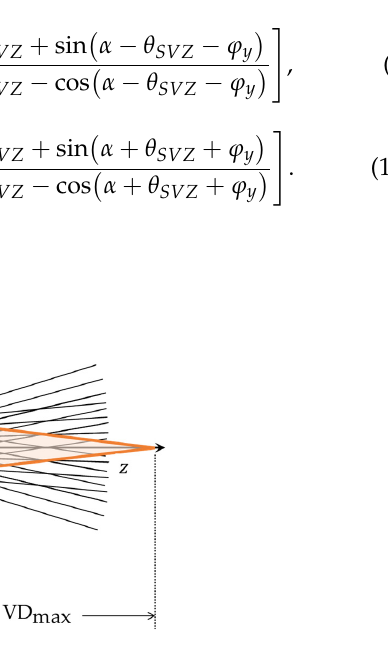
Figure 3. Formation of viewing zone (VZ) from SVZs in a multiview